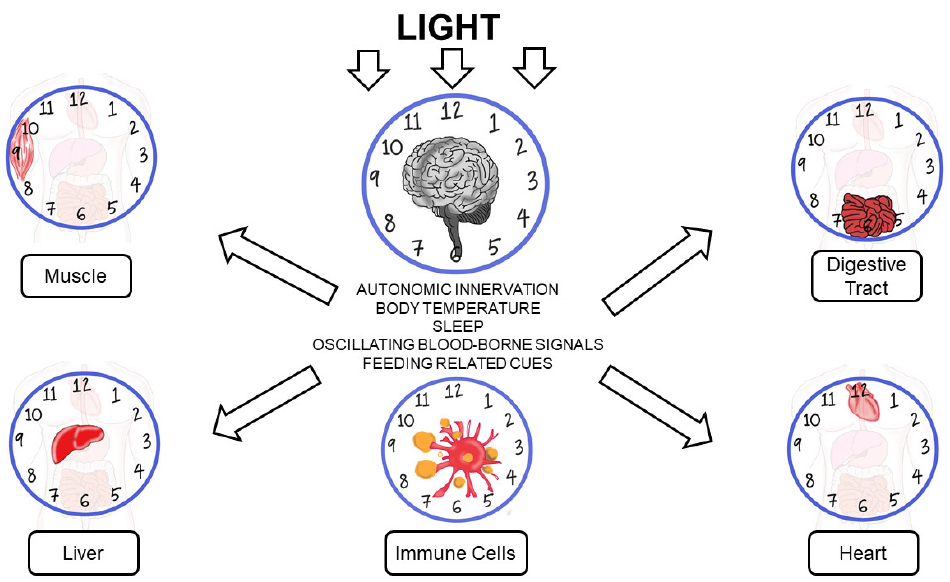
Figure 1. Biological clock in heart, digestive tract, liver, muscle, and immune cells.